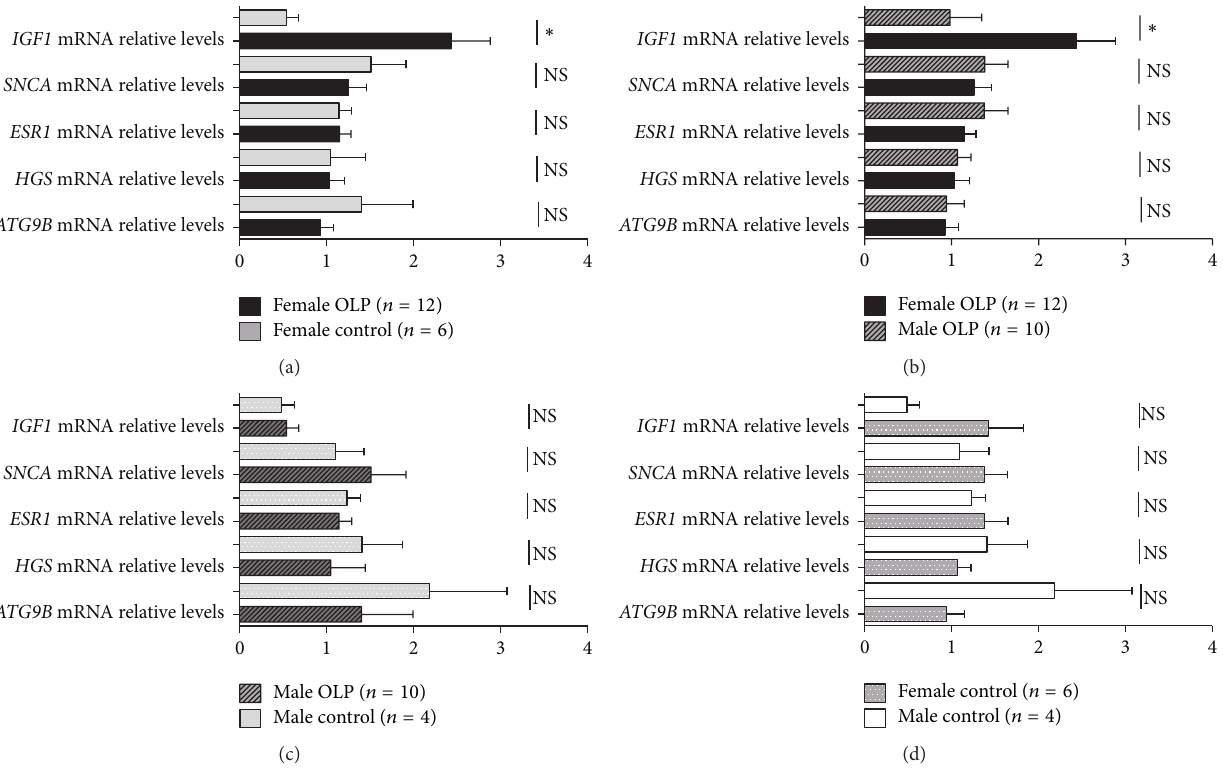
Figure 4: Expression of IGF1 , ATG9B , HGS , ESR1 , and SNCA mRNA in T cells from different genders of OLP patients and controls. Data were presented as mean ± SEM ( ∗ 𝑝 < 0.05; NS: